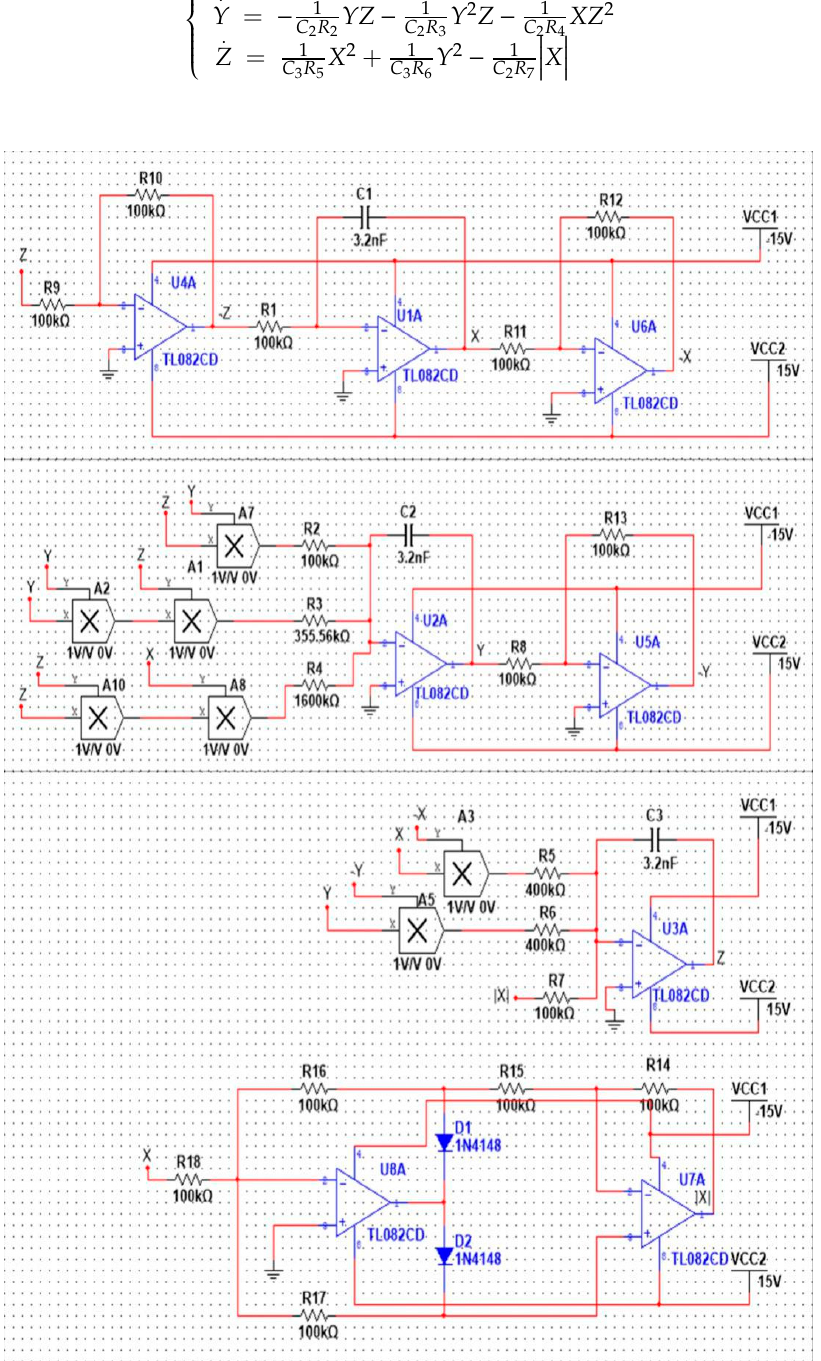
Figure 6. The circuit schematic diagram of the new chaotic system.